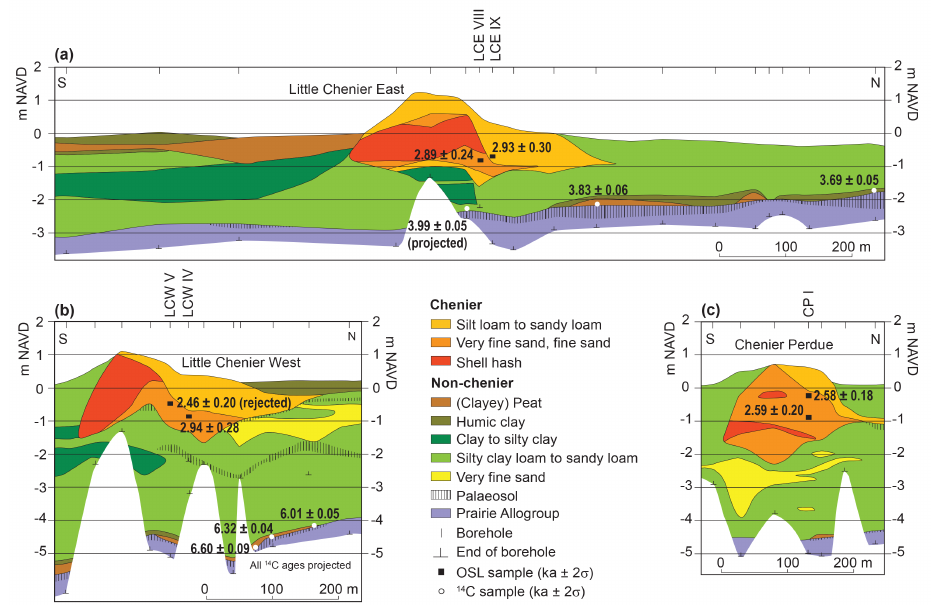
Figure 3. Cross sections across (a) Little Chenier East, (b) Little Chenier West and (c) Chenier Perdue with the stratigraphic position of the OSL samples (Table 1). For location of cross sections see Fig. 2. The radiocarbon ages are from Yu et al. (2012).